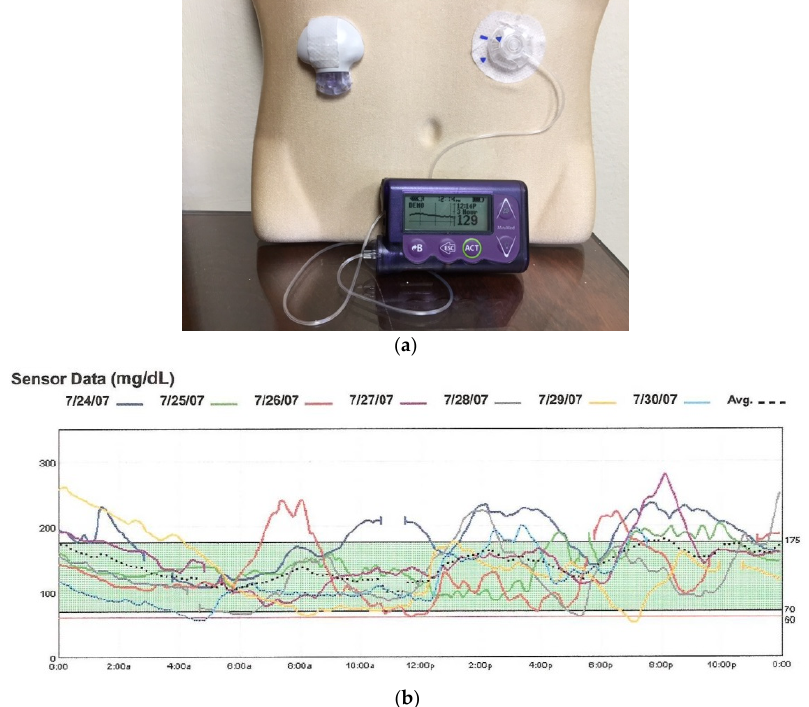
Figure 6. The EnLite Medtronic Real Time Continuous Glucose Sensor and Transmitter on the right in ( a ), integrated with the 530G Insulin Pump (Sensor-Augmented Pump Therapy). Downloaded 7-day tracing from the CareLink software are shown in ( b ).